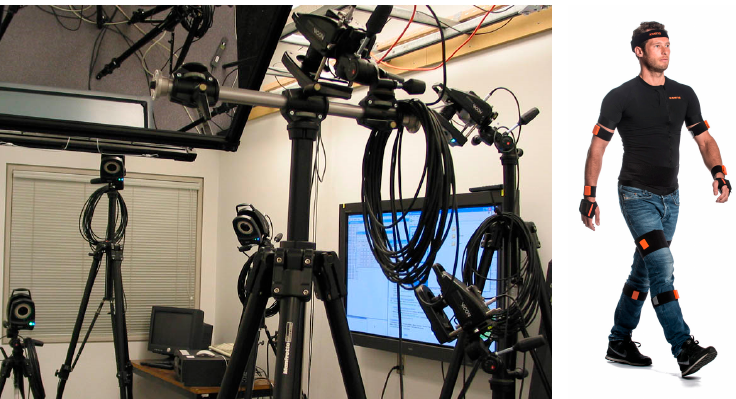
Figure 1. The set of sensors from the optical motion tracking system: VICON ( left ) and IMU-based sensors mounted on the human body ( right ).